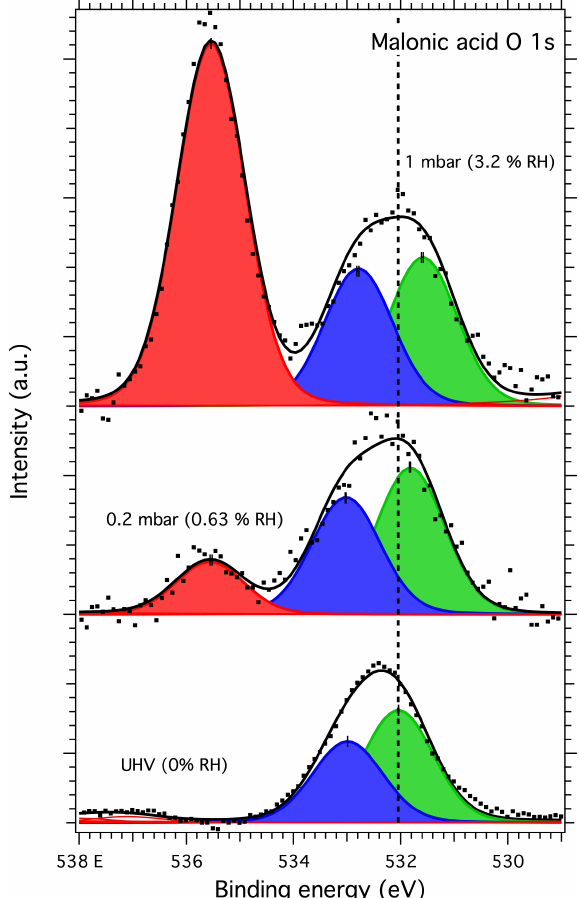
Figure 8. O 1s spectra of malonic acid aerosol particles. The dots show the recorded data, the solid lines the fit envelope curve and the red, blue and green peaks the water vapor, C–OH and C=O com- ponents, respectively. The dashed vertical line shows the binding energy of the C=O component at 0mbar pressure (0% RH) at the beginning of the experiments. Error bars show the estimated un- certainty in the peak position from Monte Carlo analysis. Photon energy was 1253.6eV from the Mg